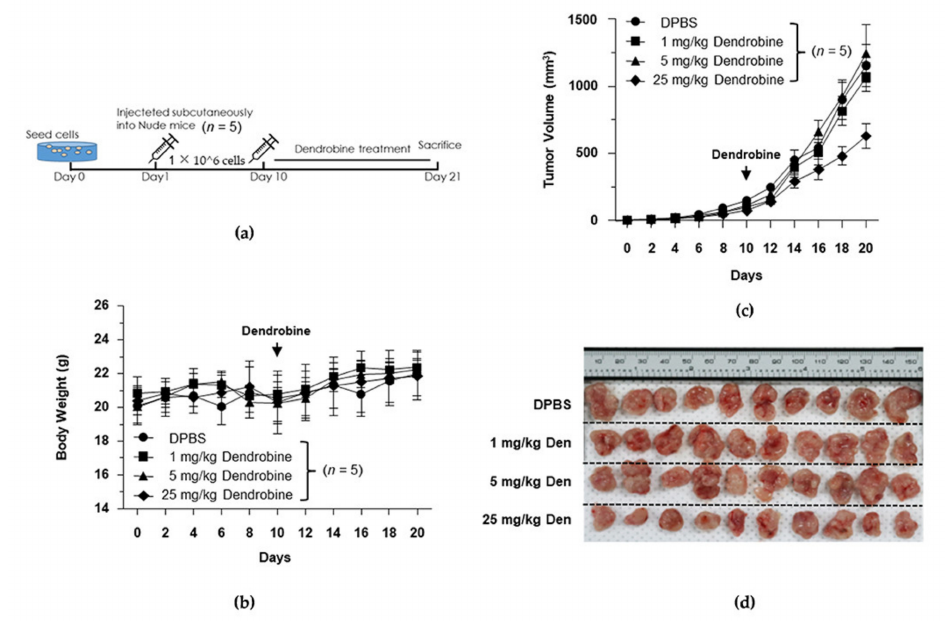
Figure 5. Inhibitory effects of dendrobine on tumor growth in a xenograft model. ( a ) Schematic diagram of the experimental design for investigating the inhibitory effects of dendrobine on tumor growth. ( b ) Changes in mouse body weights. ( c ) Changes in mouse tumor volumes. ( d ) Image of tumors isolated at the end of the